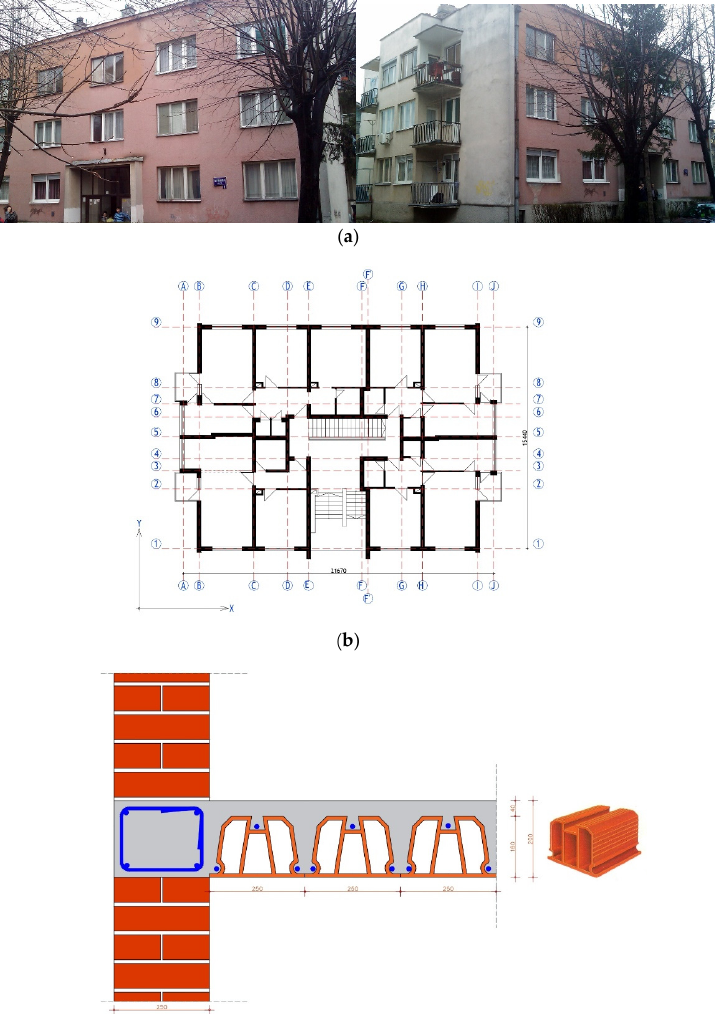
Figure 8. Case study building in Kraljevo, Serbia: ( a ) exterior views; ( b ) floor plan at ground floor level, and ( c ) floor system.